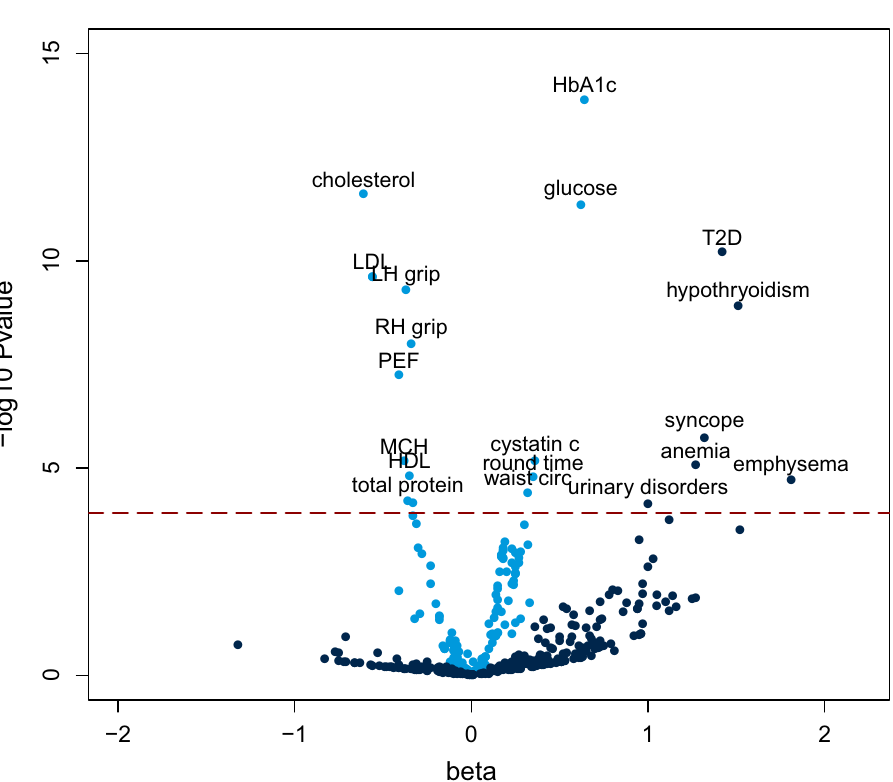
Figure 3. PheWAS of GIGYF1 pLOF. The x-axis is the beta (effect size in standard deviations) for the association and the y-axis is − log10 (p-value). Quantitative traits are colored light blue and ICD10 diagnoses colored dark blue. Phenome-wide significant associations are labeled. The dashed line indicates the p-value threshold for phenome-wide significance. Protein; total protein, RH grip; right hand grip strength, round time: time to complete round (cognitive test), LH grip; left hand grip strength, PEF; peak expiratory